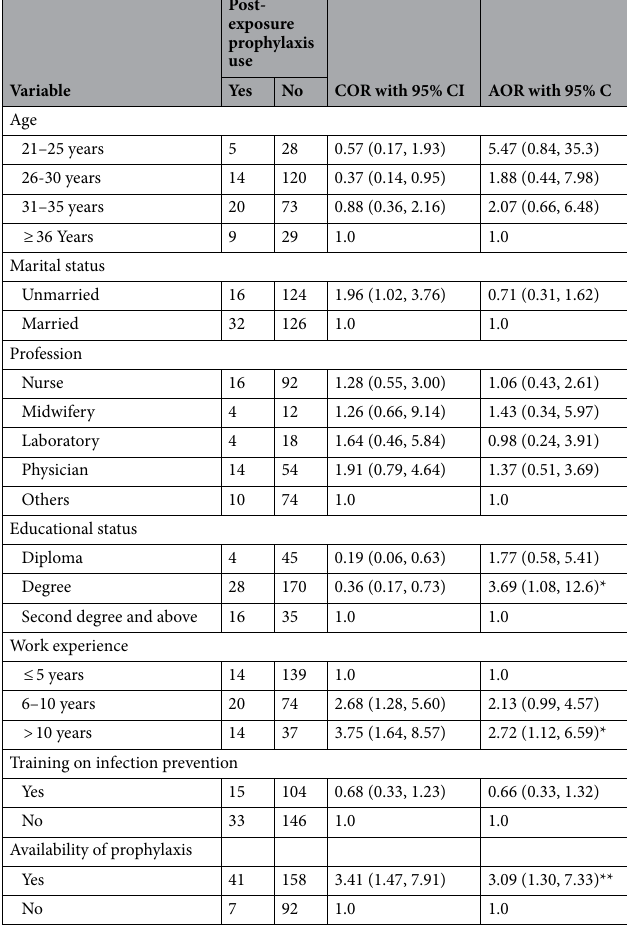
Table 5. Factors associated with utilization of post-exposure prophylaxis among healthcare workers at St. Peter’s specialized hospital in Addis Ababa, Ethiopia, April 2022. *Statistically significant at p < 0.05, ** statistically significant at p < 0.01. AOR adjusted odds ratio, CI Confidence interval Hosmer and Lemeshow test = 0.285, other professional = public health officer, anesthetists, psychiatry, radiographer, pharmacypersonnels, and